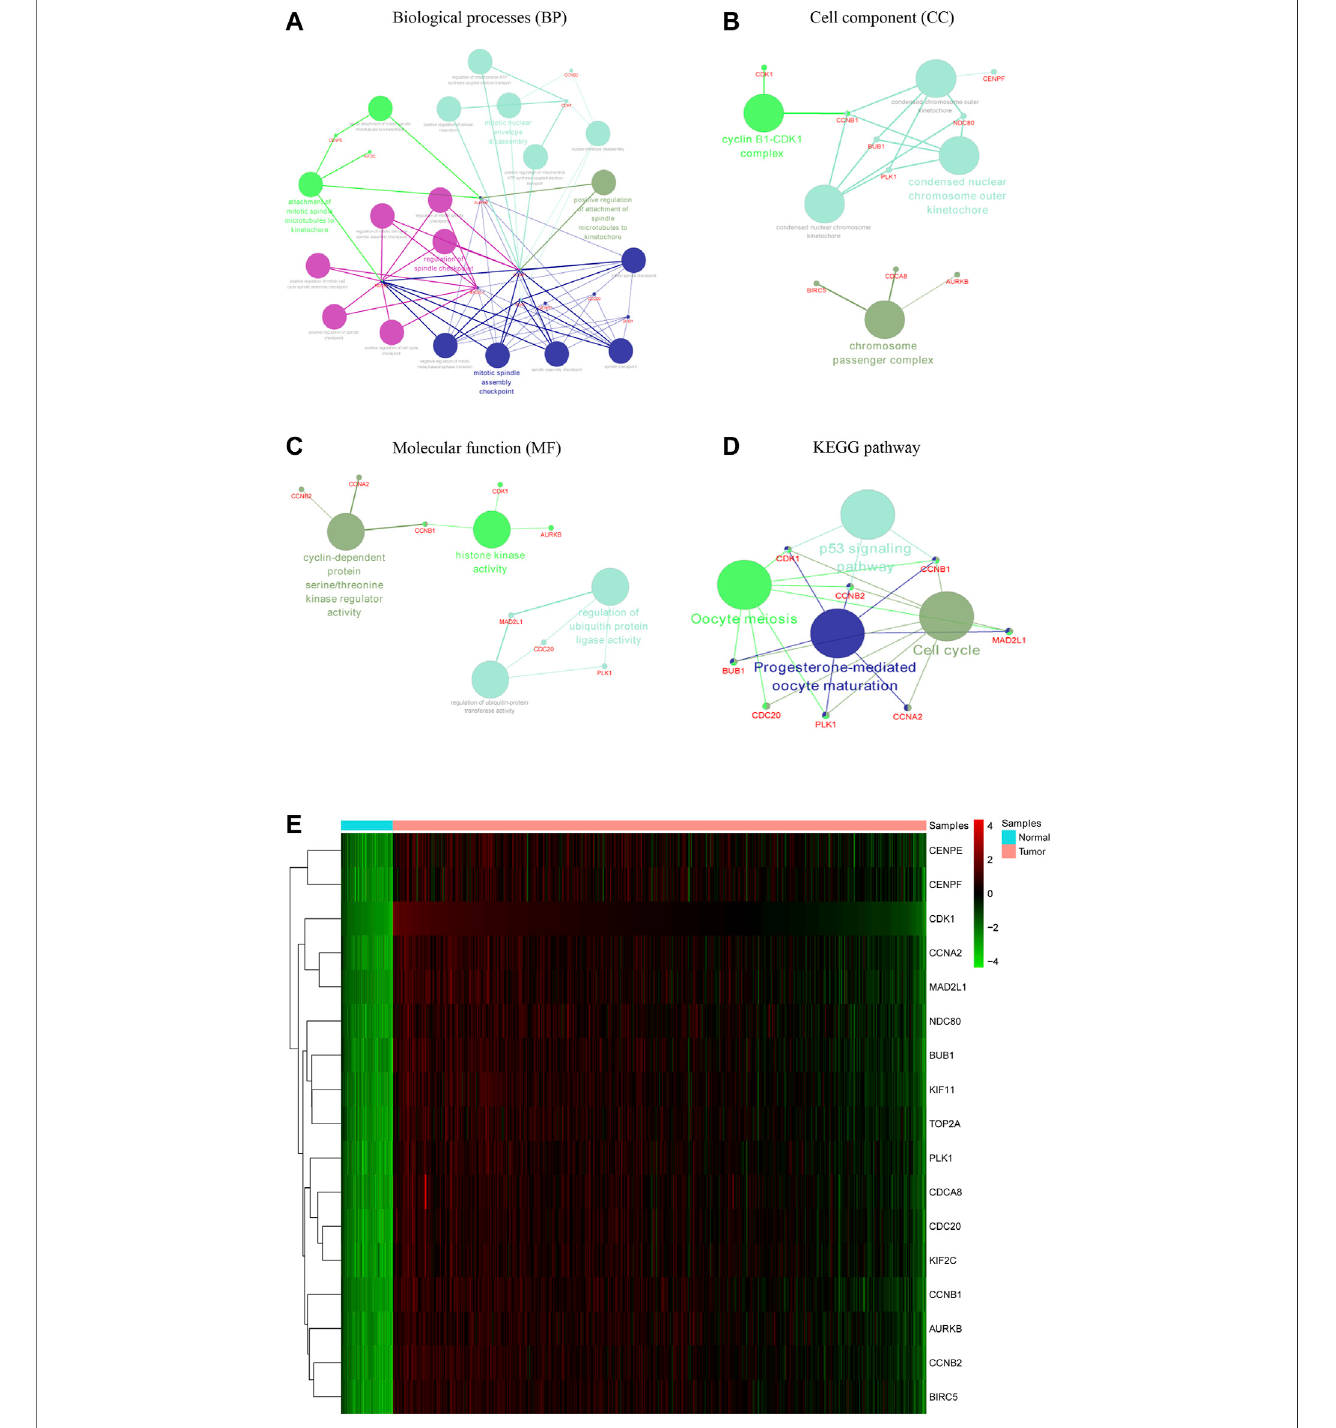
FIGURE 4 | Functional enrichment analysis and heat map of these hub genes. The biological processes (BP), cell component (CC), and molecular function (MF) analysis of hub genes are performed using ClueGO (A – C) . The KEGG pathway analysis of hub genes is performed using ClueGO (D) . The two terms are marked in the same colors if they are similar, and the size of nodes refers to the p -value of biological process analysis. The hub genes participating in these terms are shown, and they areconnectedwithrelevanttermsbysolidlines.HeatmapofhubgenesisconstructedbasedondatafromTCGAandvisualizedusingpheatmappackage (E) .Up- regulation is marked in red, while down-regulation is marked in